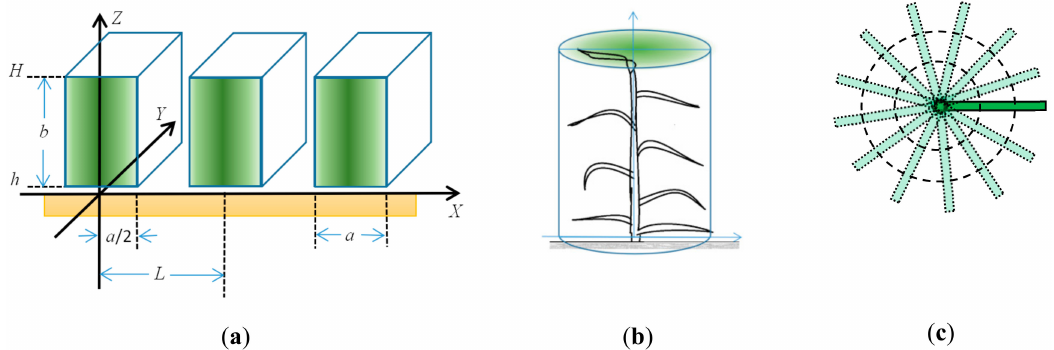
Figure 1. Coordinate system for row crop scene and for an individual plant. ( a ) The Cartesian coordinate system for the row structure. L is the distance between two neighboring rows, a is the width of row, b is the thickness of row, and H and h are the heights of upper and bottom edge of row. ( b ) The cylindrical coordinate system for individual scale. ( c ) The top-view sketch of leaf occurrence